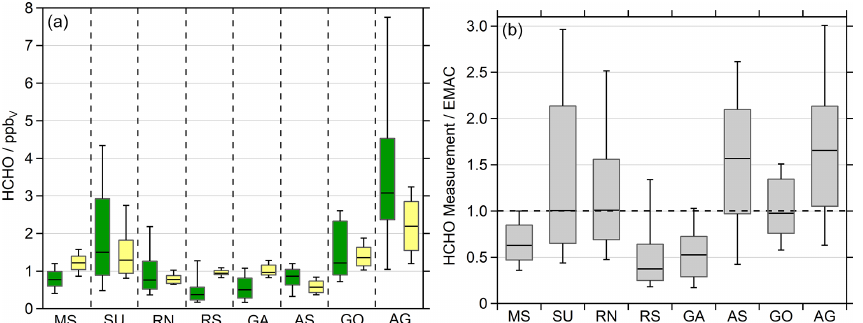
Figure 3. Formaldehyde observations (green) and EMAC simulations (yellow) divided into the eight regions during AQABA: Mediterranean Sea (MS), Suez Canal (SU), Red Sea north (RN), Red Sea south (RS), Gulf of Aden (GA), Arabian Sea (AS), Gulf of Oman (GO) and Arabian Gulf (AG). We used the lowermost model results ( ∼ 30m) for the comparison in 10min averages (a) . The box represents 25% to 75% of the data, and the whiskers are from 10% to 90% with the median as the black line. Panel (b) shows the ratio between the observations and the model simulations.